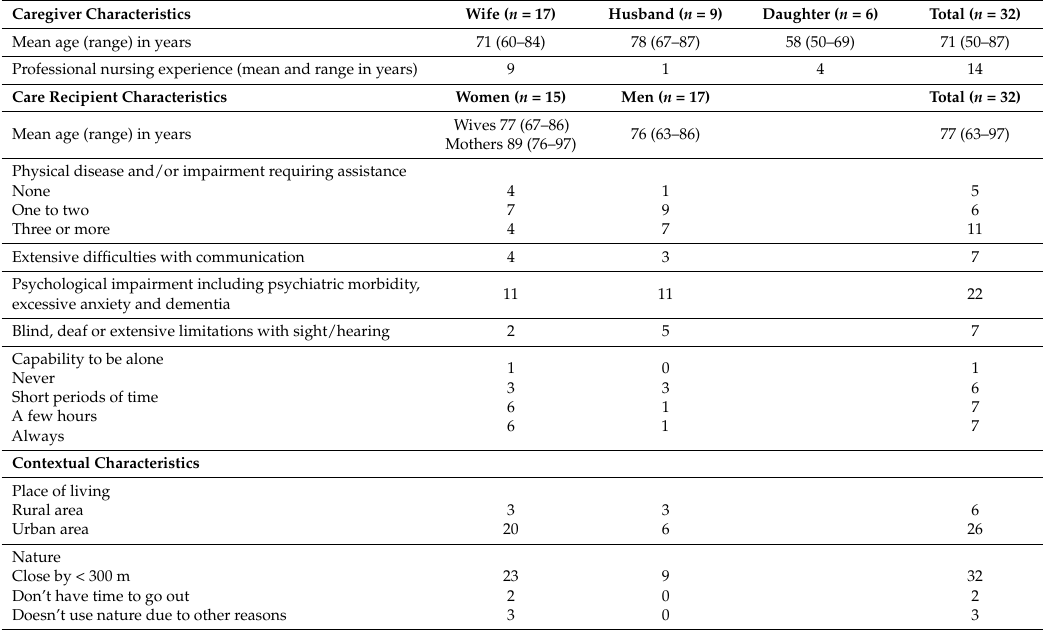
Table 1. Characteristics of caregivers, care recipients and the